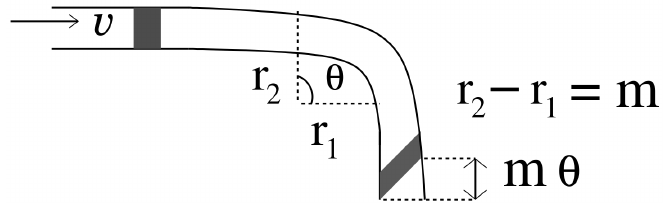
Figure 3. Signal propagation in a microfluidic channel with a